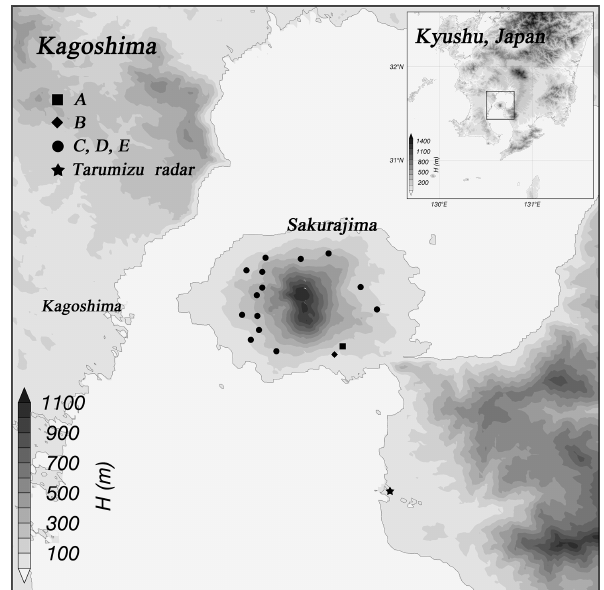
Figure 3. The locations of tephrometers and Showa crater on Saku- rajima, Japan. Black symbols indicate the locations of tephrometers, and the star, square, and circle symbols correspond to data sets A, B and C–E, respectively. The white circle symbol represents the lo- cation of Showa